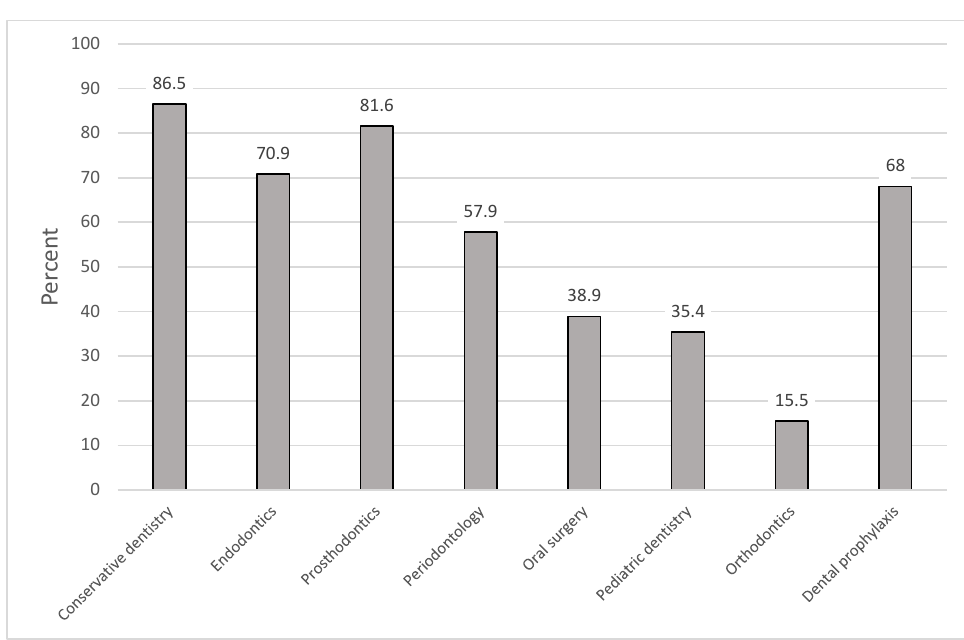
Figure 1. Distribution of field of work of participating dentists (multiple answers possible) .